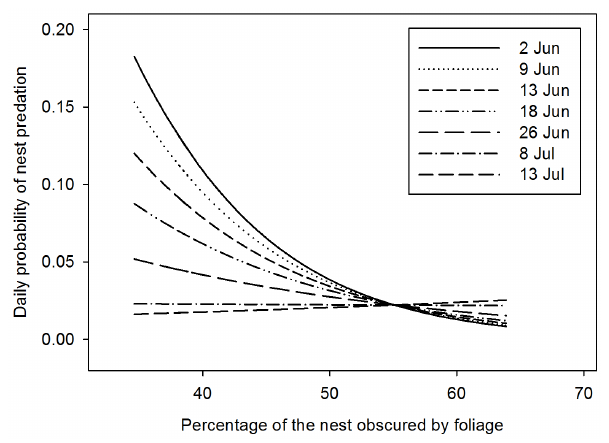
Figure 3. Daily probability of nest predation in relation to foliage density. Estimates of daily probability of nest predation for Dusky Flycatchers as a function of the percentage of the nest obscured by foliage generated from the best-supported model in step 2 of our modeling approach (Nest predation=Foliage density + Date + Foliage Density*Date; Table 2). The effect of foliage density on daily nest predation was assessed at seven representative dates throughout the breeding season. Daily nest predation was negatively associated with foliage density early in the breeding season (2–18 June), but not late in the breeding season (after foliage density had matured on , 10 July; see Fig. 2).